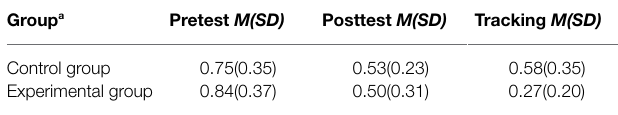
TABLE 4 | Mean IAT effect values (D) by